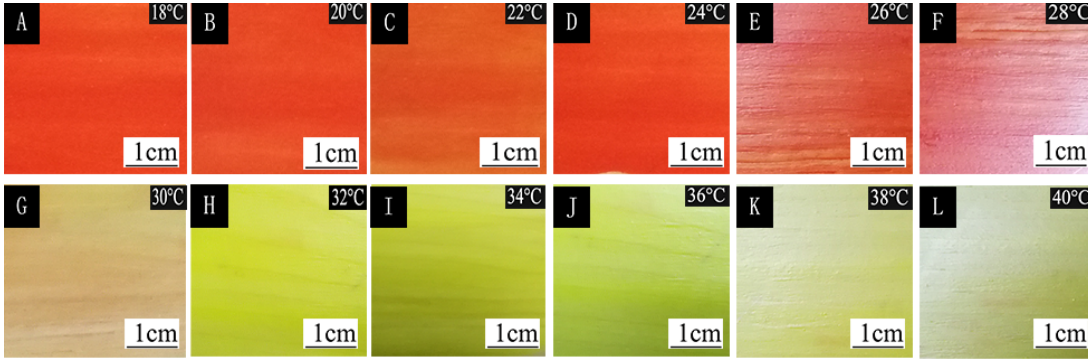
Figure 7. Image of Sample #1 from 18 to 40 C.